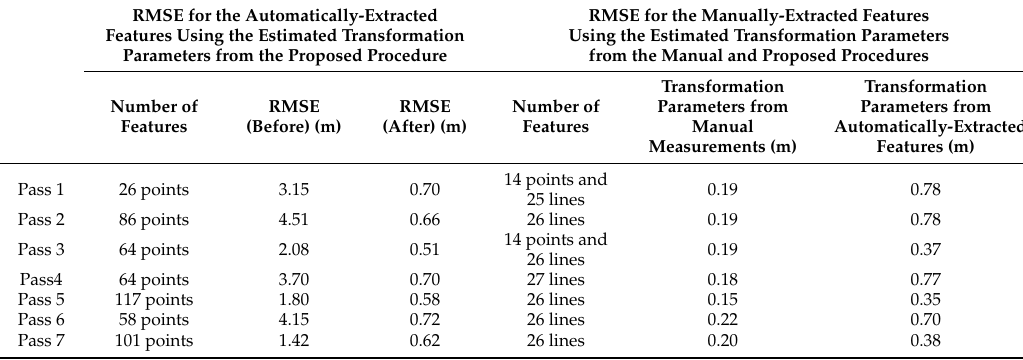
Table 4. Accuracy assessment of the quality of fit between the RGB-based and hyperspectral data before and after the geometric refinement for the acquired hyperspectral data on 21 August 2015. RMSE for the Automatically-Extracted RMSE for the Manually-Extracted Features Features Using the Estimated Transformation Using the Estimated Transformation Parameters Parameters from the Proposed Procedure from the Manual and Proposed Procedures Number of